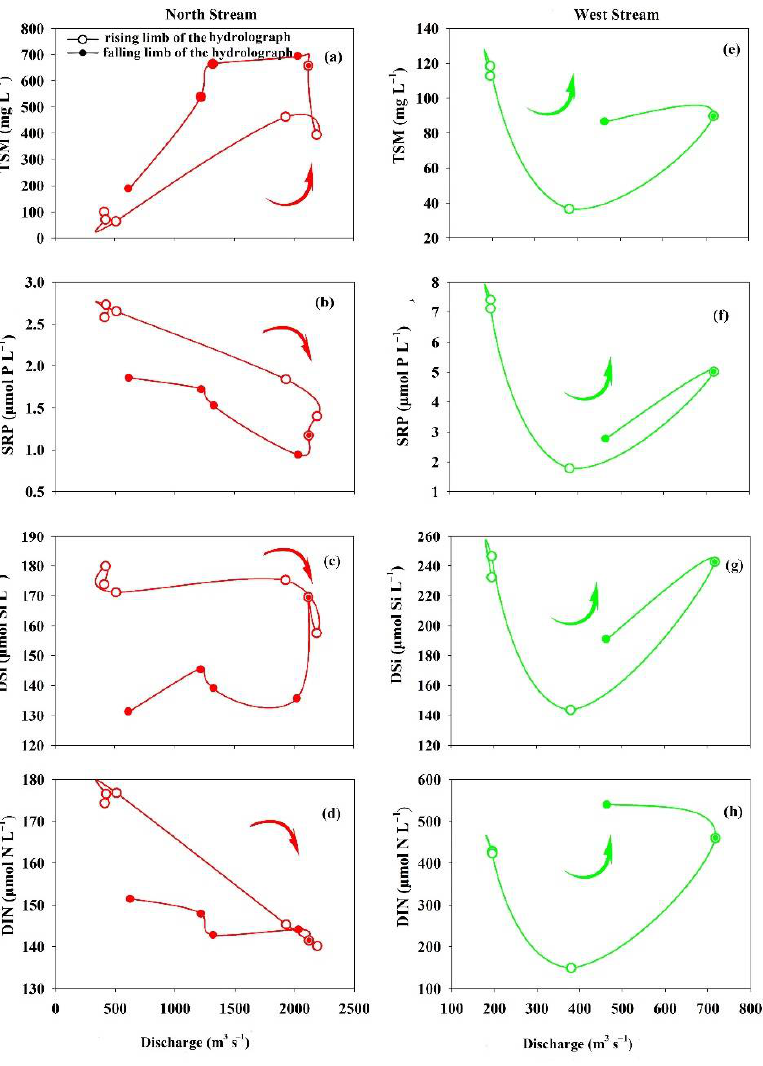
Figure 6. The trajectory of TSM ( a , e ), SRP ( b , f ), DSi ( c , g ) and DIN ( d , h ) values along with river discharge during the rain event in the NS ( a – d ) and the WS ( e – h ).